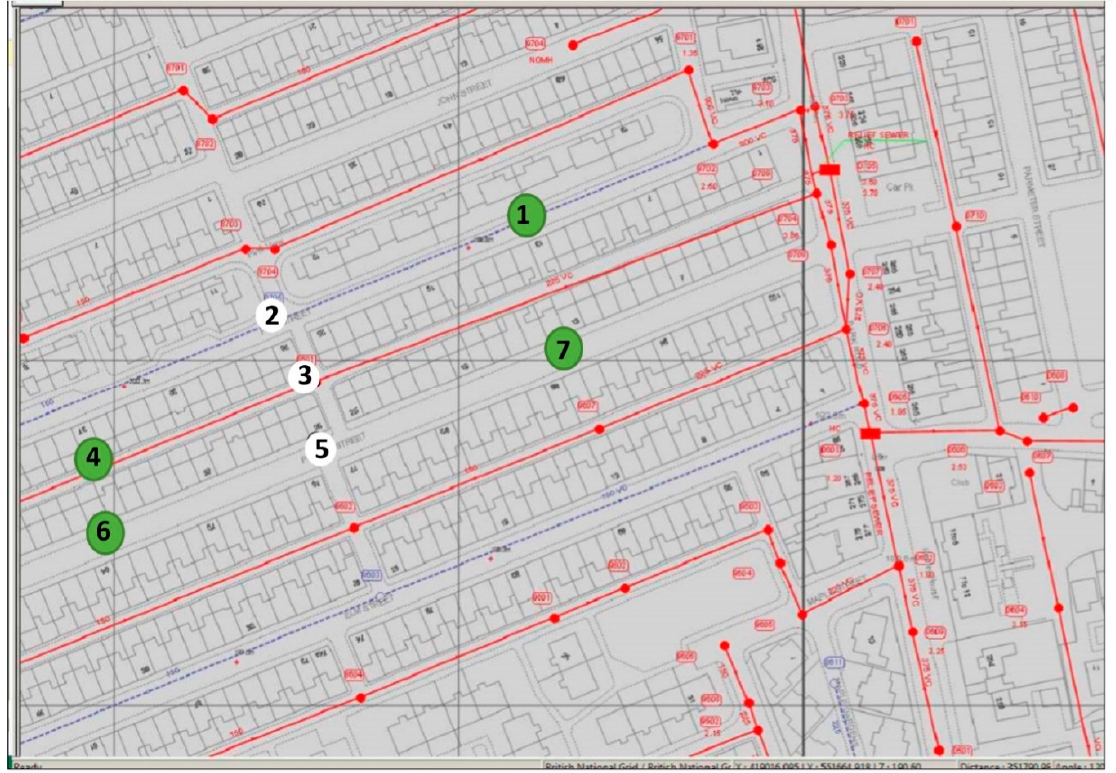
Figure 6. Locations for monitoring equipment in South Moor’s sewer network following inspection in late February 2018. Green dots show manholes suitable for installation of sensor, white dots show manholes not used in this study. Red lines highlight foul or combined sewers, and blue lines show surface water sewers. The position of private drains and sewers are not shown.